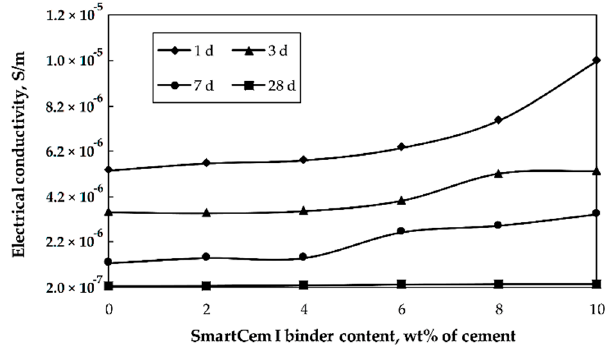
Figure 8. E ff ects of age and amount of SmartCem I content on the measured electrical Figure 8. Effects of age and amount of SmartCem I content on the measured electrical conductivity.